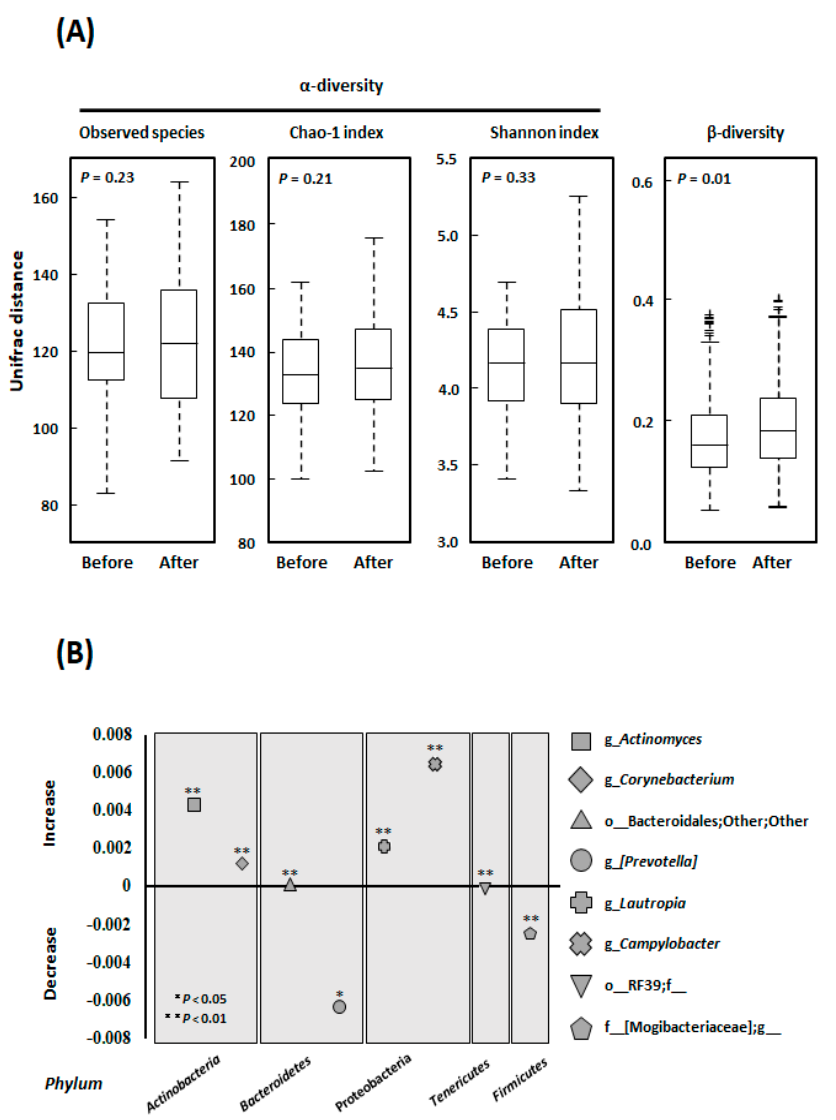
Figure 2. ( A ) Changes in the alpha-diversity and beta-diversity in the E group. The alpha-diversity indices (Observed species, Chao 1 index [operational taxonomic unit (out) richness estimation], and Shannon index [OTU evenness estimation]) and beta diversity indices were compared using Student’s unpaired t-tests (Bonferroni-corrected). ( B ) Comparative analyses of the taxonomic composition of the microbial community at the genus and higher levels. The populations of the genera Actinomyces , Corynebacterium , Lautropia , and Campylobacter significantly increased, as did that of the order Bacteroidales during exercise. In contrast, the populations of the genus Prevotella , order RF39 , and family Mogibacteriaceae significantly decreased. * p < 0.05, ** p < 0.01 for baseline vs. three